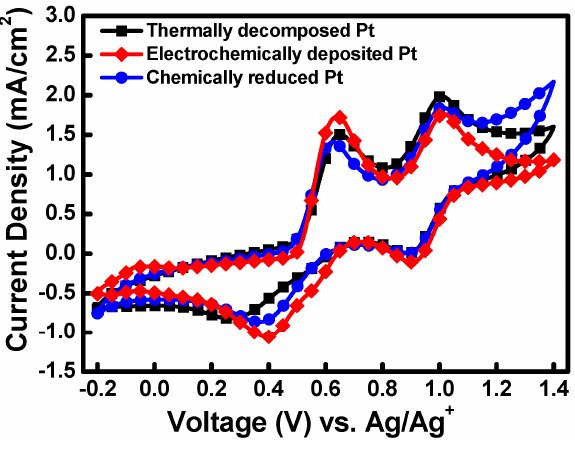
Figure 5. Cyclic voltammograms of various Pt CEs.